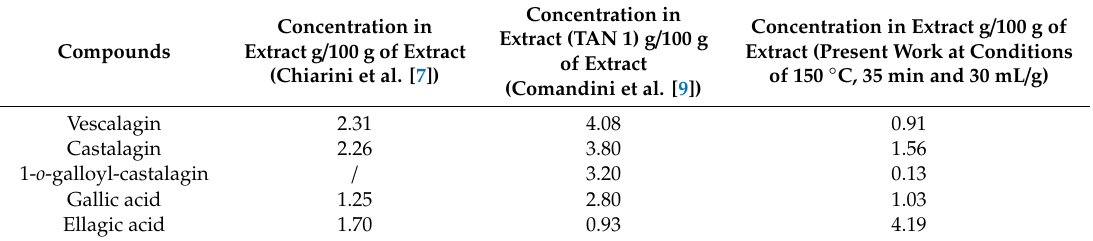
Table 6. Concentration of ellagitannins, gallic acid and ellagic acid in chestnut bark extracts obtained by di ff erent methods.